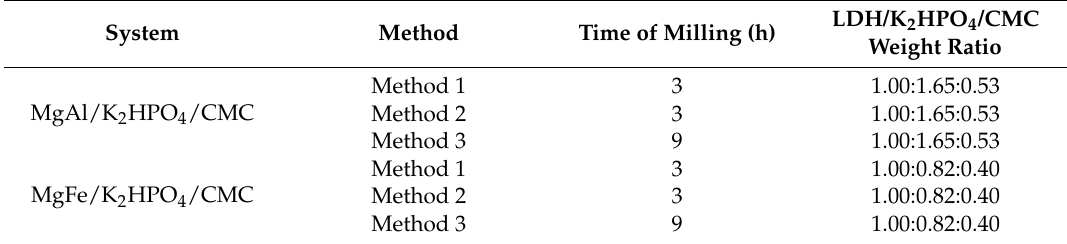
Table 1. Description of the three methods used to incorporate carboxymethylcellulose (CMC) into the systems’ layered double hydroxides (LDH) matrices calcined at 200 ◦